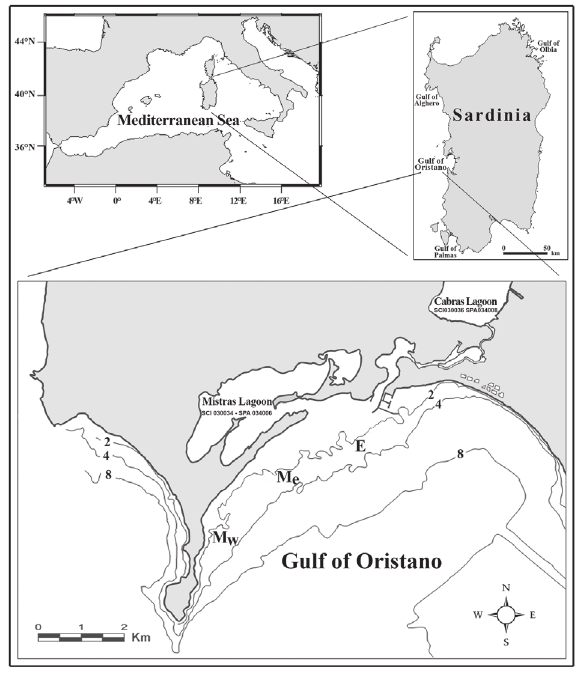
Fig . 1. − the Gulf of oristano location with the sampling stations where Pinna nobilis populations were